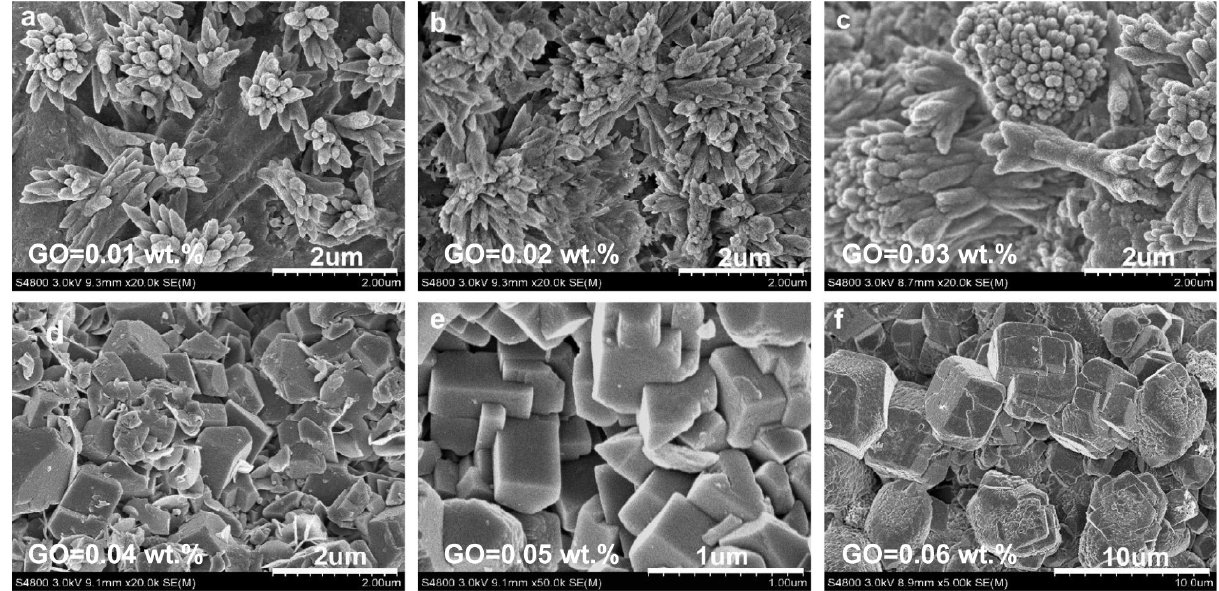
Figure 8: Effects of different proportions of GO sheets on the shapes of cement hydration crystals and their formation process [110]